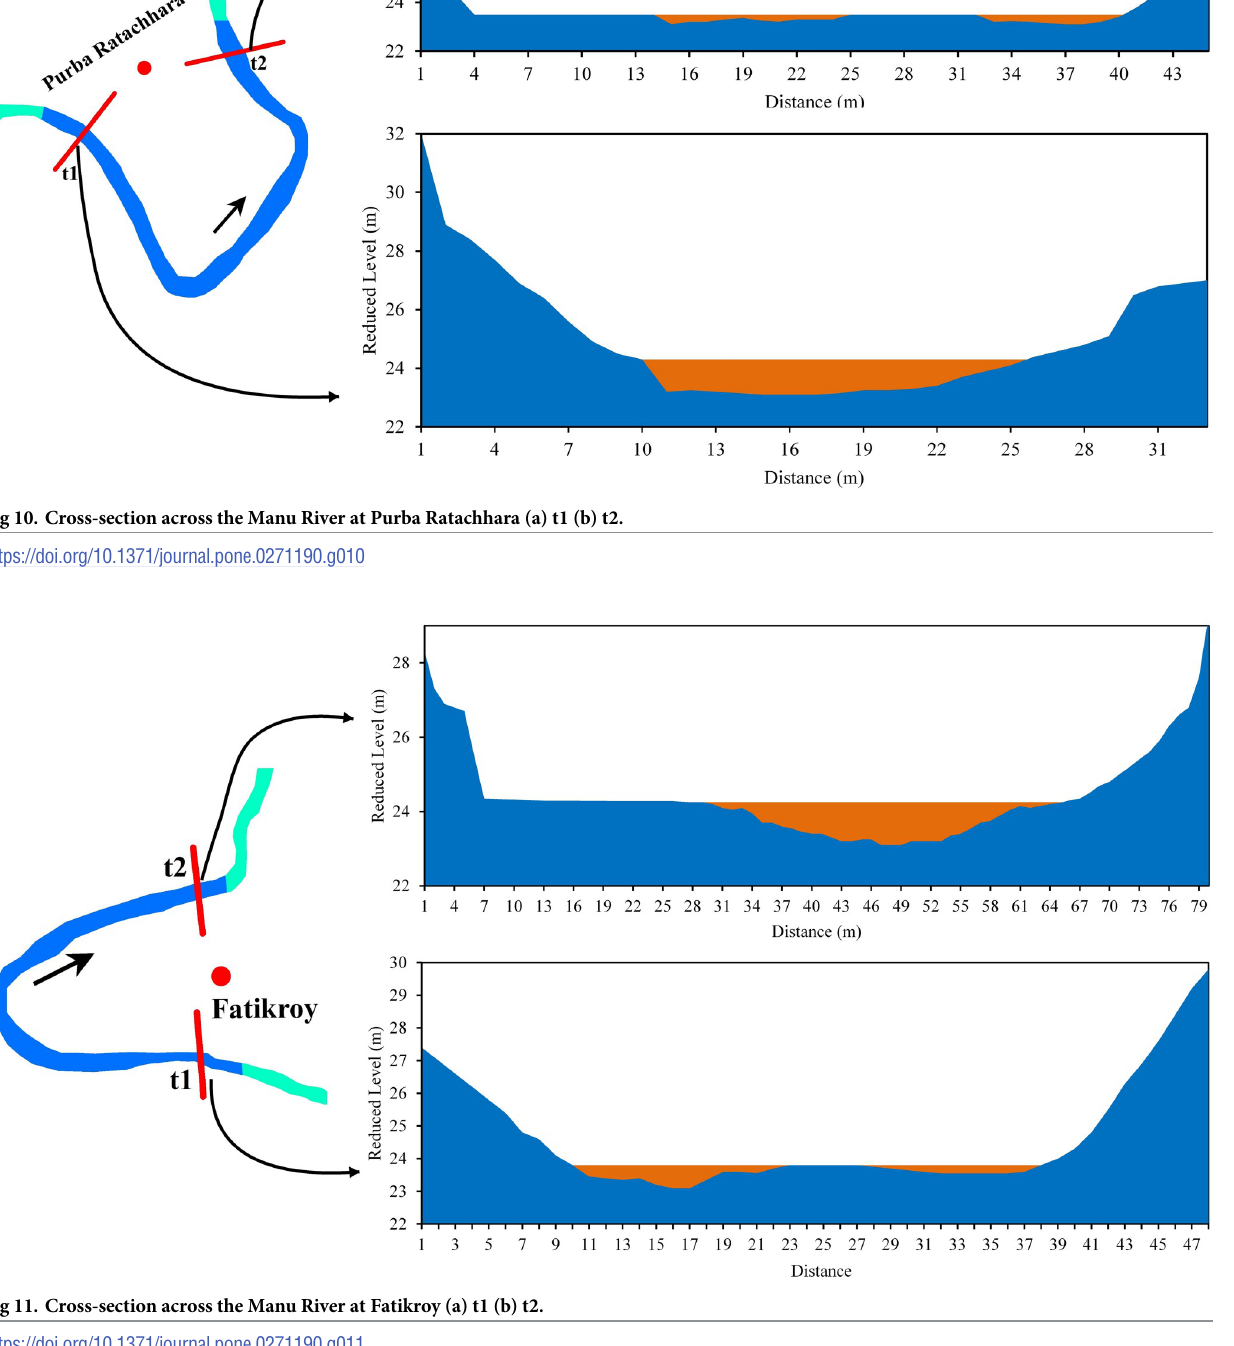
PLOS ONE | https://doi.org/10.1371/journal.pone.0271190 July 20, 2022 17 /